Question: In one sentence, what is this figure communicating?
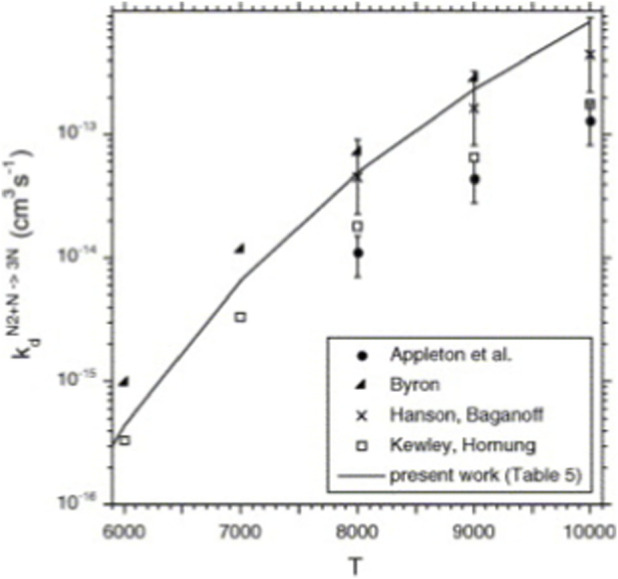
Answer: Experimental measurements (points) and Esposito work ( Esposito et al., 2006 ) (line) global dissociation rate coefficients versus T for the process N 2 +N→3N.